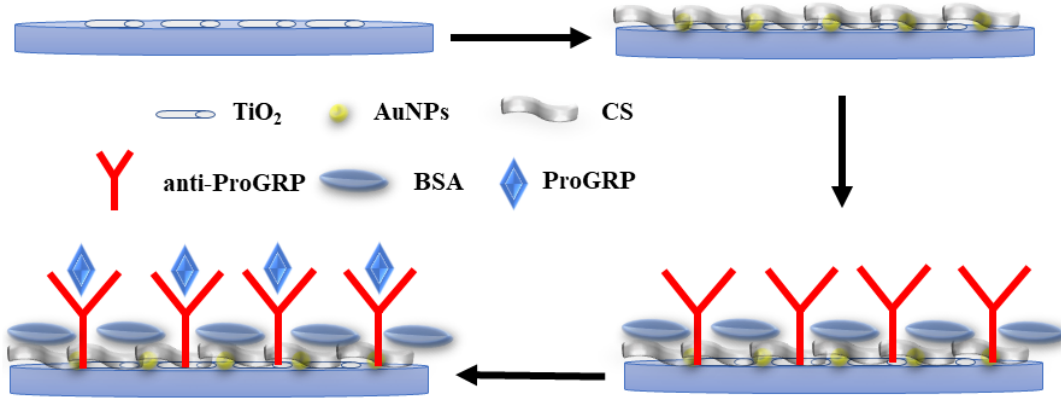
Scheme 1. Schematic diagram of the construction of proposed electrochemical immunosensor.